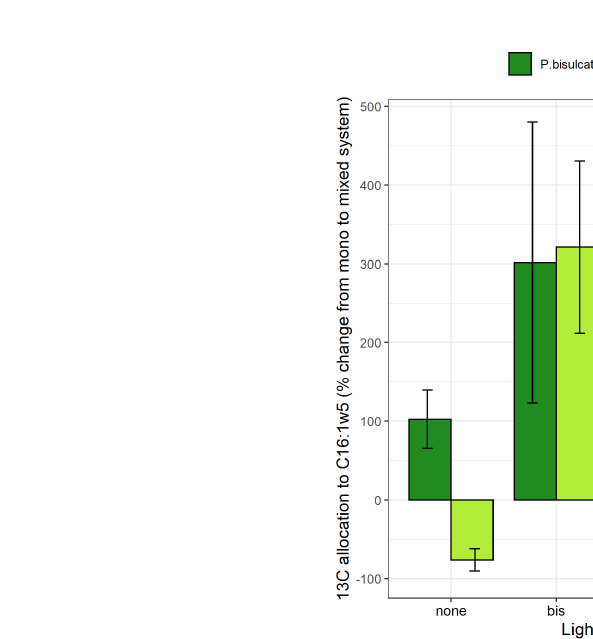
FIGURE 5 The effects of light regime and plant species ( P.bisulcatum and P.maximum ) on 13 C allocation to the mycorrhiza-speci fi c fatty acid C16:1 w 5 in mycorrhizal pots in mixed system compared with mono system. Light regime: none (no shading), full (both plants are shaded), bis ( P.bisulcatum is shaded) and max ( P.maximum is